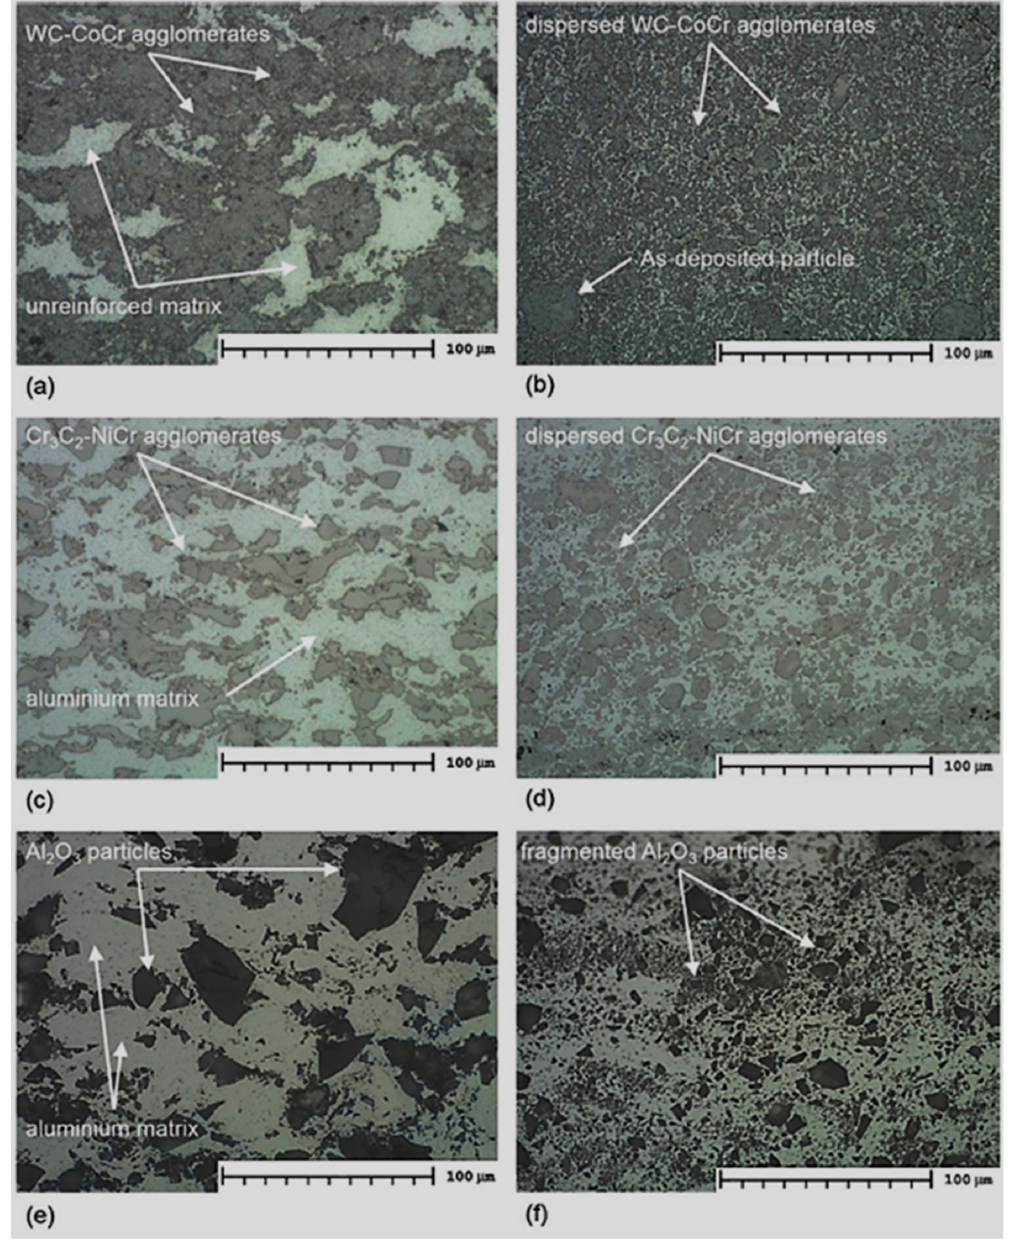
Figure 10. Optical micrographs of the Al matrix composite coatings: ( a ) as-deposited WC-CoCr; ( b ) spray stirred WC-CoCr; ( c ) as-deposited Cr 3 C 2 -NiCr; ( d ) spray stirred Cr 3 C 2 -NiCr; ( e ) as-deposited Al 2 O 3 ; and ( f ) spray stirred Al 2 O 3 (adapted from reference [56] , with permission from © Elsevier).